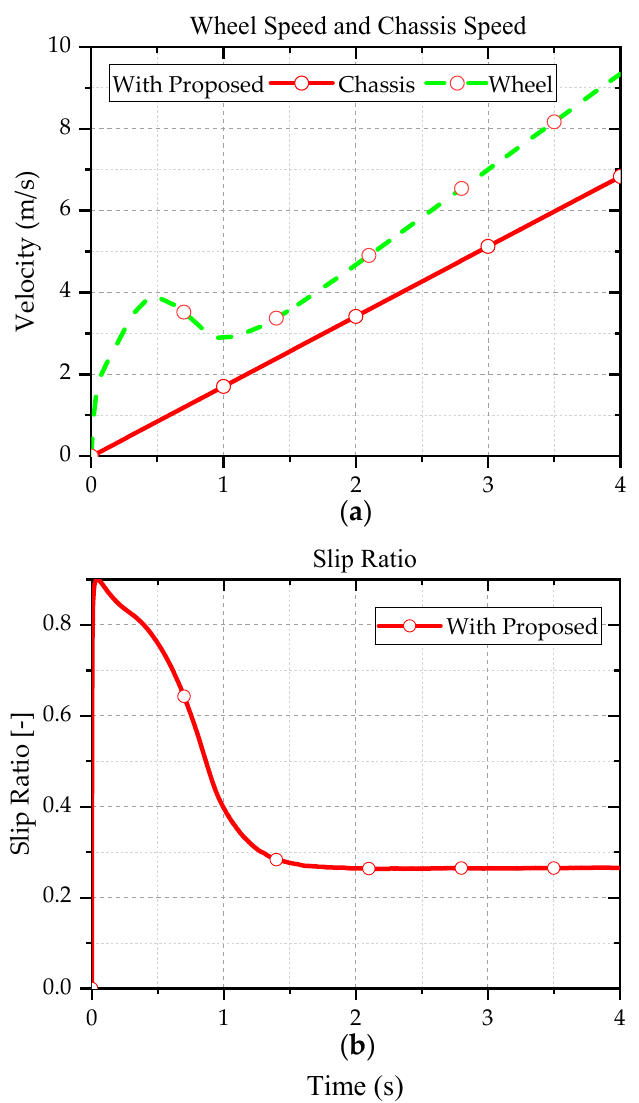
Figure 13. Simulation results of vehicle starting from standstill: ( a ) front-left wheel speed and chassis speed; ( b ) slip ratio of front-left wheel.